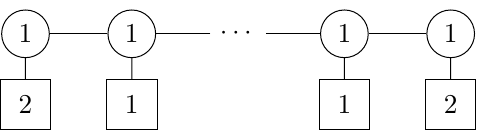
Figure 14 . Abelian A r (cid:0) 1 quiver with one fundamental at each interior node and two fundamentals at the outermost nodes. In this picture the CS levels are all set to